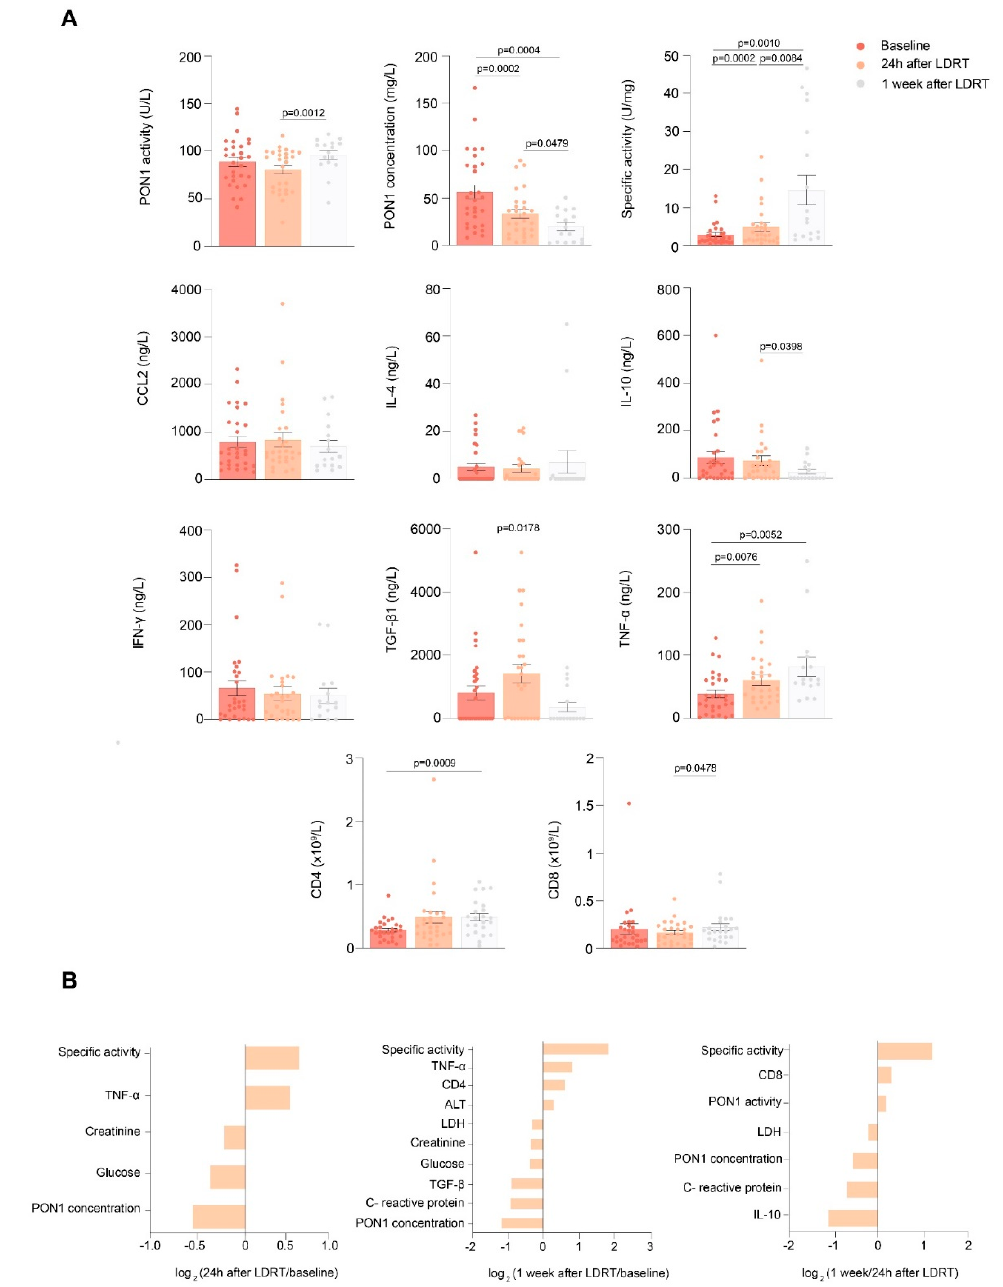
Figure 1. ( A ) Serum paraoxonase-1 (PON1)-related variables and selected cytokines and immuno- logical markers in patients with COVID-19 pneumonia before and after low-dose radiation therapy (LDRT). ( B ) Magnitude of change of selected variables, shown as log 2 fold change. Abbreviations: CCL2, chemokine (C-C motif) ligand 2; CD, cluster of differentiation; IFN- γ , interfer ó n γ ; IL, inter- leukin; LDH, lactate dehydrogenase; PON1, paraoxonase-1; TGF- β 1, transforming growth factor beta 1; TNF- α , tumor necrosis factor α